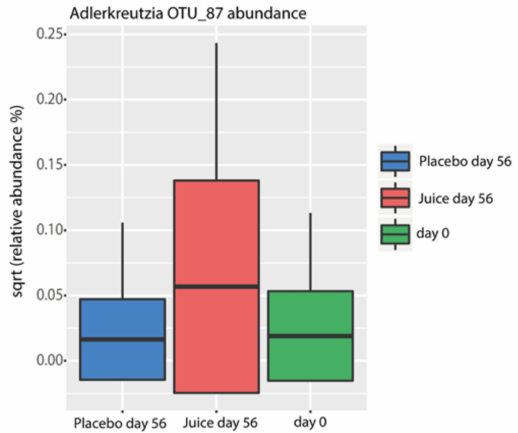
Figure 8. Square-root-normalized relative abundance of Adlercreutzia OTU 87, an indicator bacterium for treatment. (ANOVA, p = 0.0001, Tukey’s post hoc test, juice treatment d56–placebo d56: p = 0.0016,